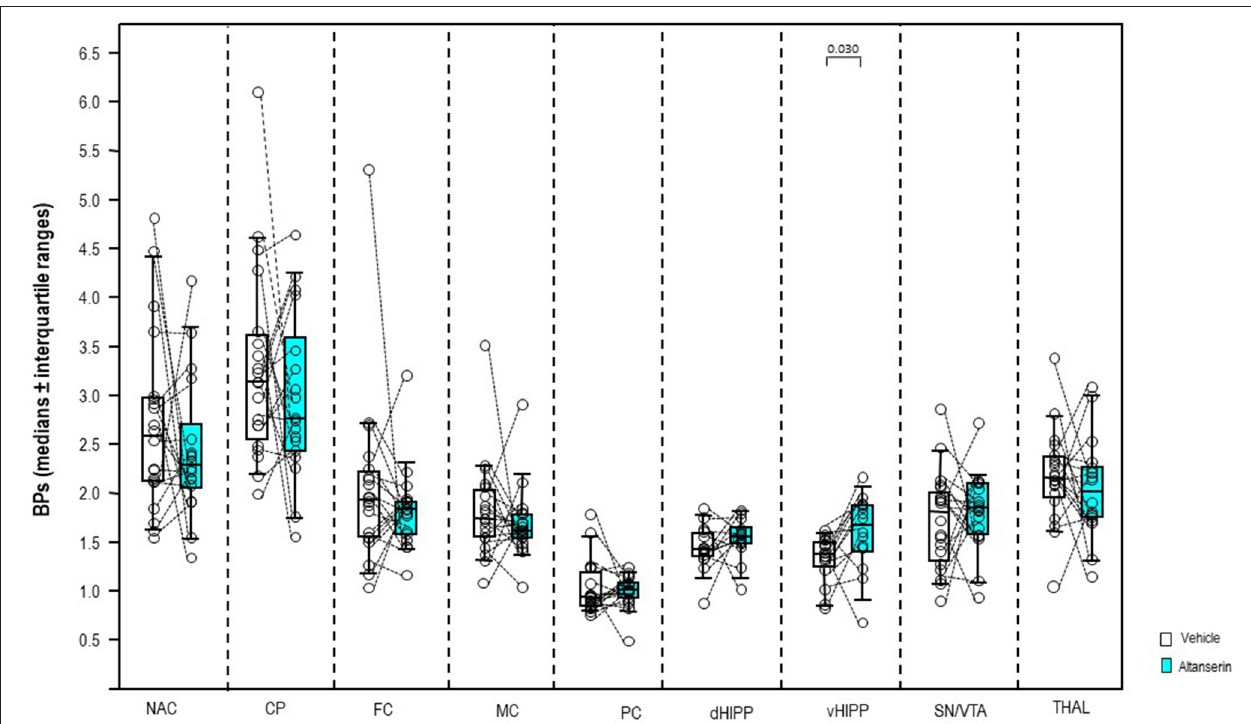
FIGURE 3 | Binding potentials (BPs) after altanserin (10 mg/kg; turquoise) and vehicle (dimethyl sulfoxide; white). Rendered are medians and 25th/75th (boxes) and 9th/95th quartiles (whiskers). The circles represent the individual animals. Treatments were compared with the Wilcoxon signed-rank test for paired samples (two-tailed, α = 0.05). The significant p -values are given. CP, caudate putamen; dHIPP, dorsal hippocampus; FC, frontal cortex; MC, motor cortex; NAC, nucleus accumbens; PC, parietal cortex; SN/VTA, substantia nigra/ventral tegmental area; THAL, thalamus (THAL); vHIPP, ventral